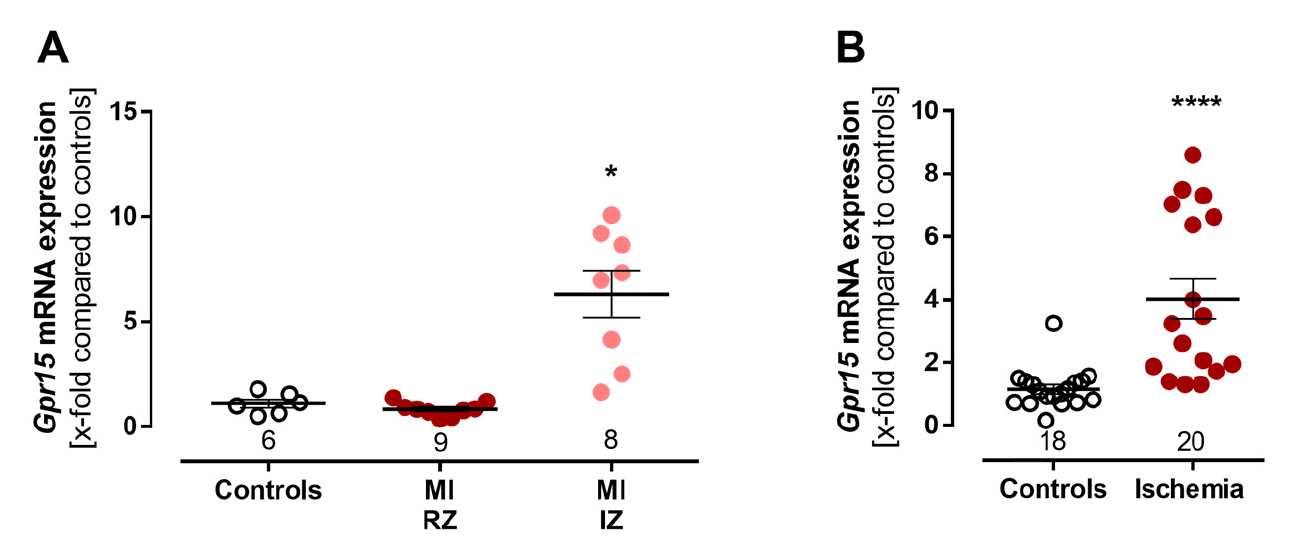
Figure 4. Experimental validation of increased Gpr15 expression after induced myocardial infarc- tion. ( A ) Validation of increased Gpr15 expression in a mouse model of myocardial infarction. Car- diac Gpr15 expression was increased 6.3-fold in the infarct zone (IZ), but not in the remote zone (RZ), five days after MI in male C57BL/6J (B6) mice. Kruskal–Wallis test with Dunn’s multiple com-